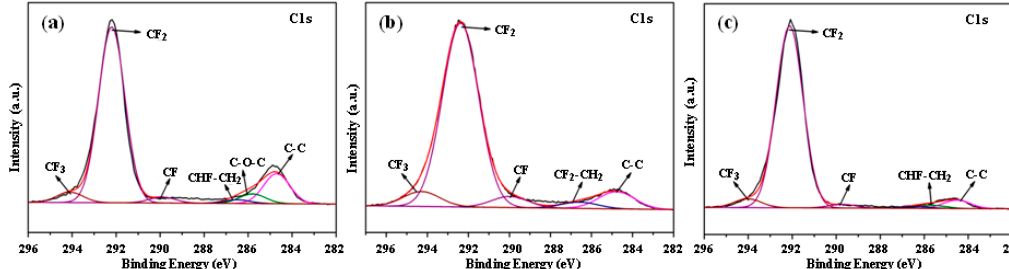
Figure 6. XPS C1s spectra of the deposited modified PVC films pretreated with ( a ) nonplasma cleaning, ( b ) Ar plasma cleaning, and ( c ) CF 4 plasma cleaning. Table 1. Contents of fluorine and carbon in the PTFE coatings with different pretreatment methods. Pretreatment methods